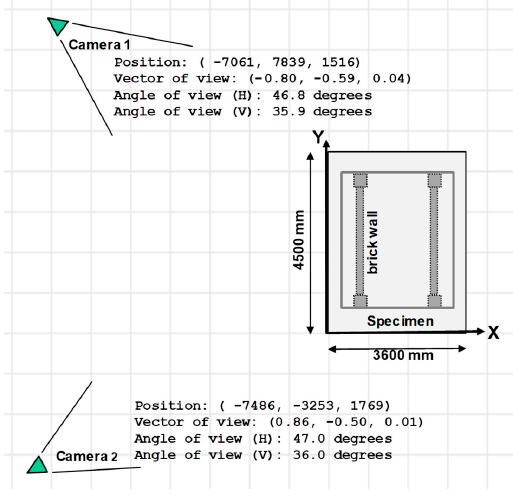
Figure 22. Estimated camera positions and viewing directions in the 1-story RC experiment. Calibrated extrinsic parameters represent the positions and orientations of cameras in the experiment.